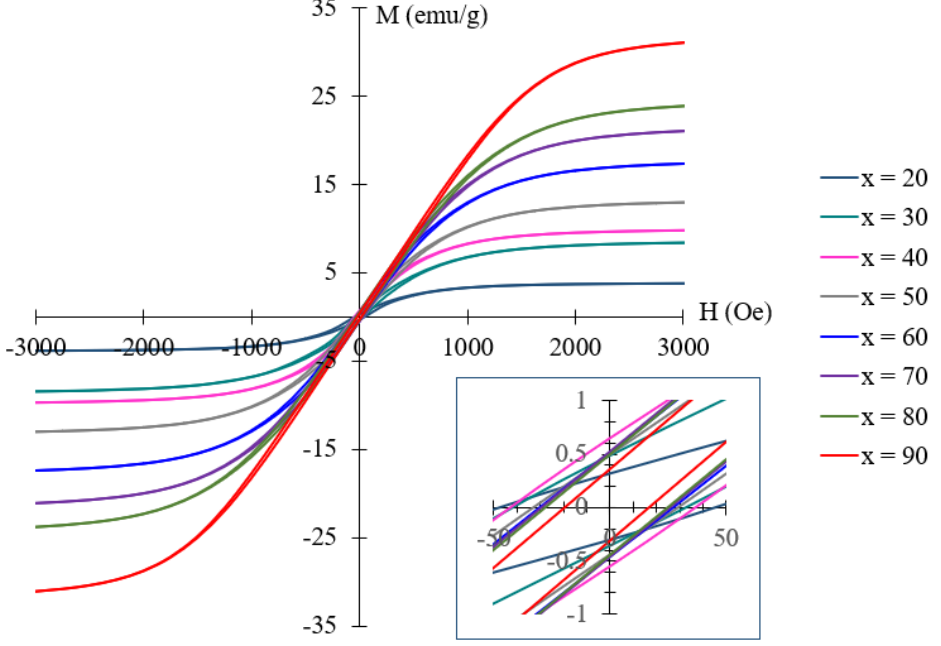
Table 1. Properties of ME composite ceramics (100 x) wt.% BCZT + x wt.% NCCMF.